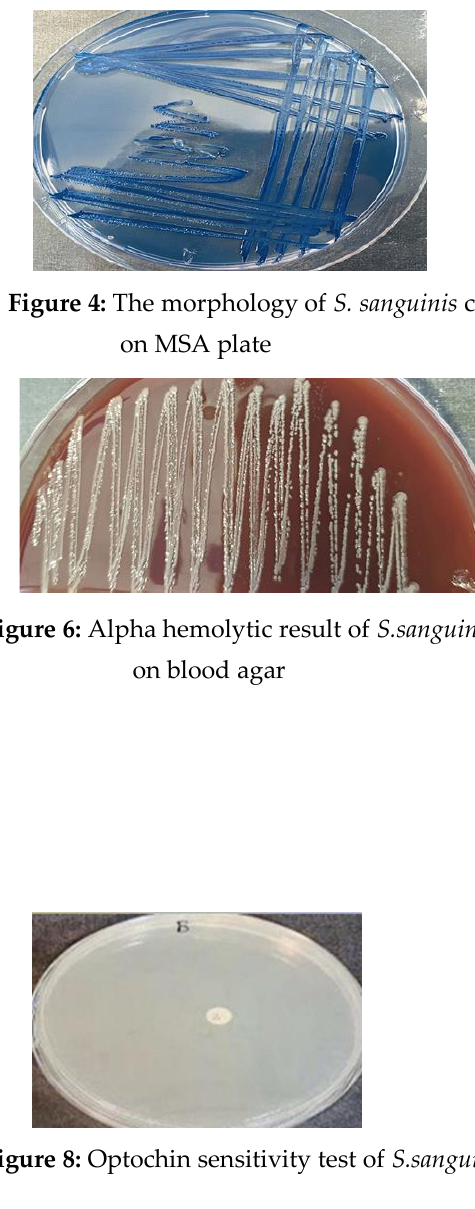
primer. M: 100bp ladder marker, Lanes resemble 313 bp PCR